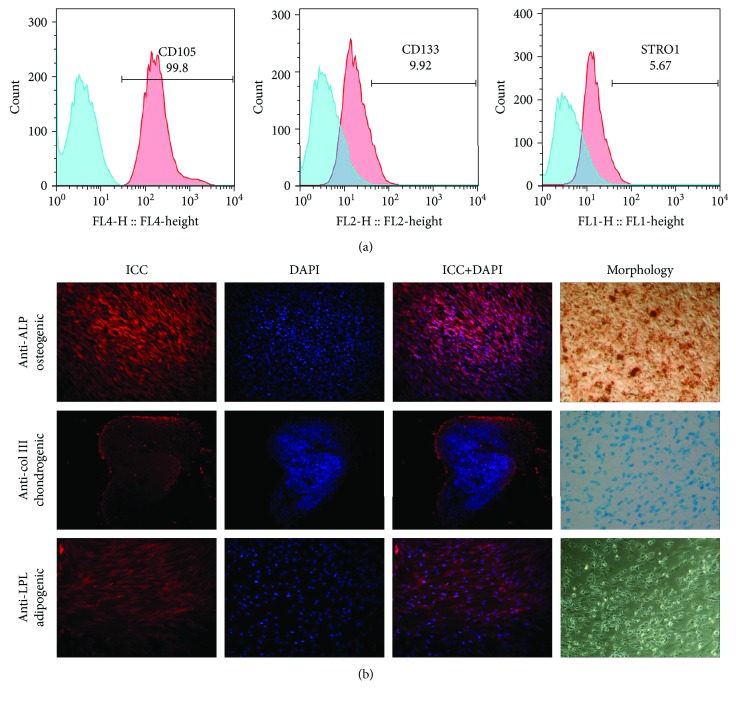
hDPC culture and identification of multidifferentiation ability: (a) identification of the mesenchymal stem cell surface markers CD105, CD133, and STRO1; (b) induced osteogenic, chondrogenic, adipogenic differentiation, and immunofluorescence staining of alkaline phosphatase (ALP), collagen type III (Col III), and lipoprotein lipase (LPL), respectively; nuclei were counterstained with 4′,6-diamidino-2-phenylindole (DAPI) (magnification 10 × 10).